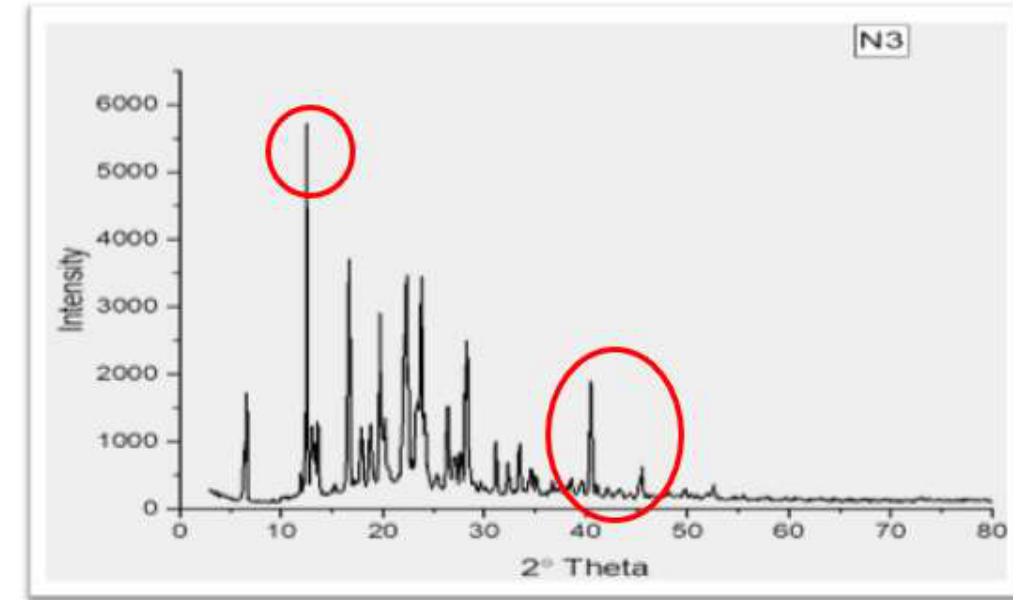
Figure 15. X-ray powder diffraction pattern of